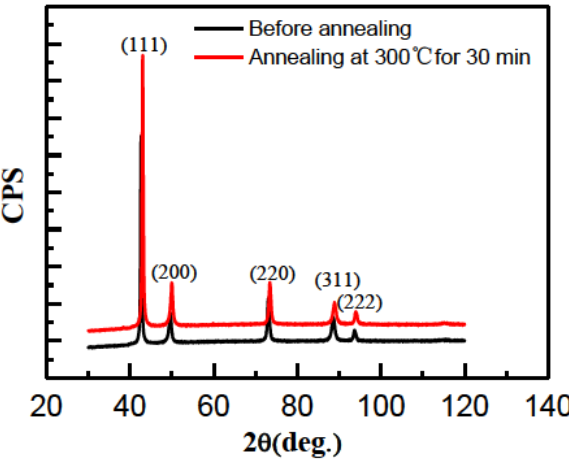
Figure 2: XRD patterns for Cu-7%Al alloy before and after annealing treatment.